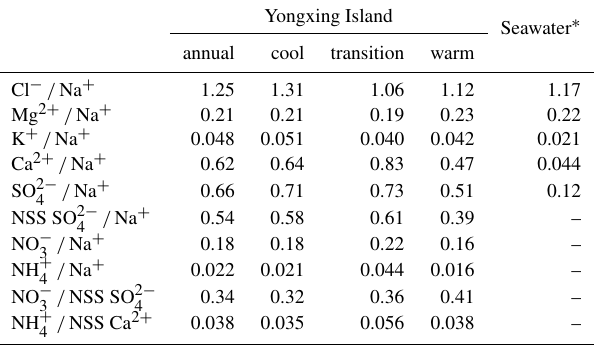
Table 2. Mole equivalent ratios for major ionic species in aerosols at Yongxing Island (annual, cool, transition and warm seasons), to- gether with seawater ratios for